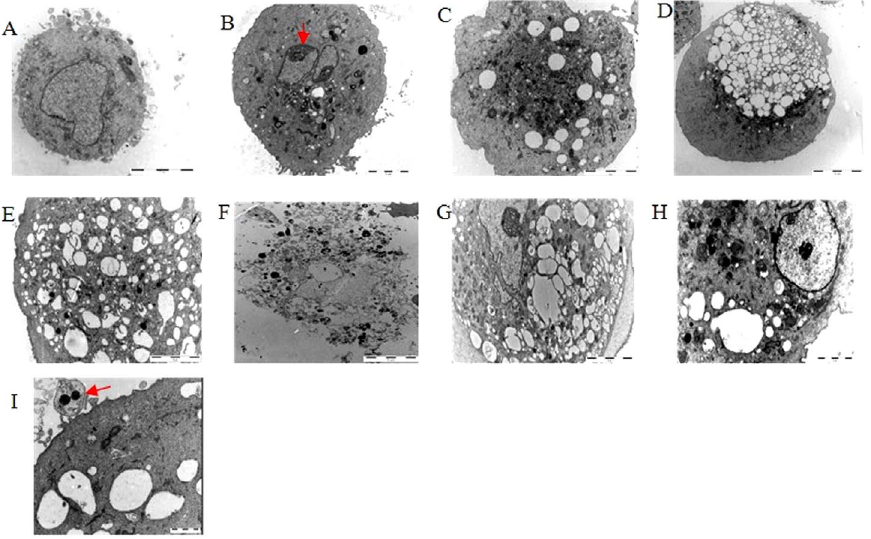
Figure 7. Representative electron microscopy images of the ultrastructural changes in astrocytes induced by mixed OGD. (A) Image of a normal astrocyte (6200 6 ). (B,I) Images of typical apoptotic cells (the red arrowhead shows chromatin condensation rendering a curved profile to the nucleus and apoptotic body formation). Apoptotic cells were found in almost all samples, particularly after 1 h (B) and 2 h (C) of OGD. (G–H) Images of typical oncotic-like cells. The co-existence of cellular swelling and vacuolization were found in the 3 h (D) and 4 h (E) OGD samples. After 6 h of OGD, the astrocytes were almost fragmental (F). Scale bars: I: 1 m m; H: 2 m m; D: 10 m m; all others: 5 m m.